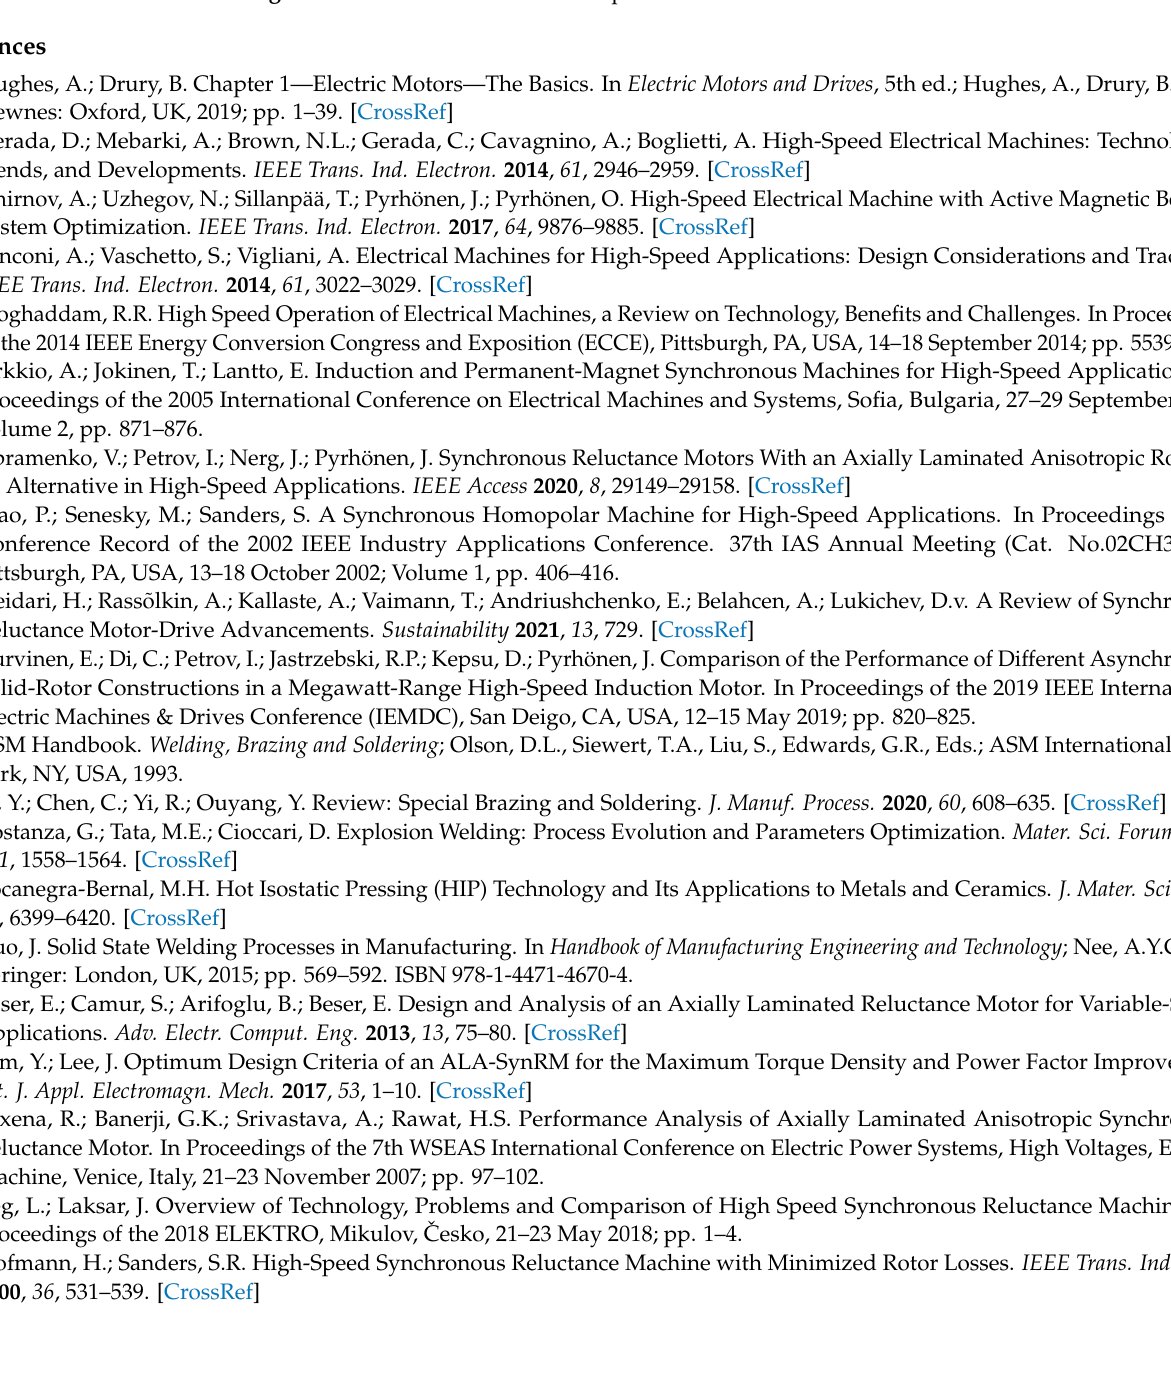
Figure A1. Fracture surfaces of test